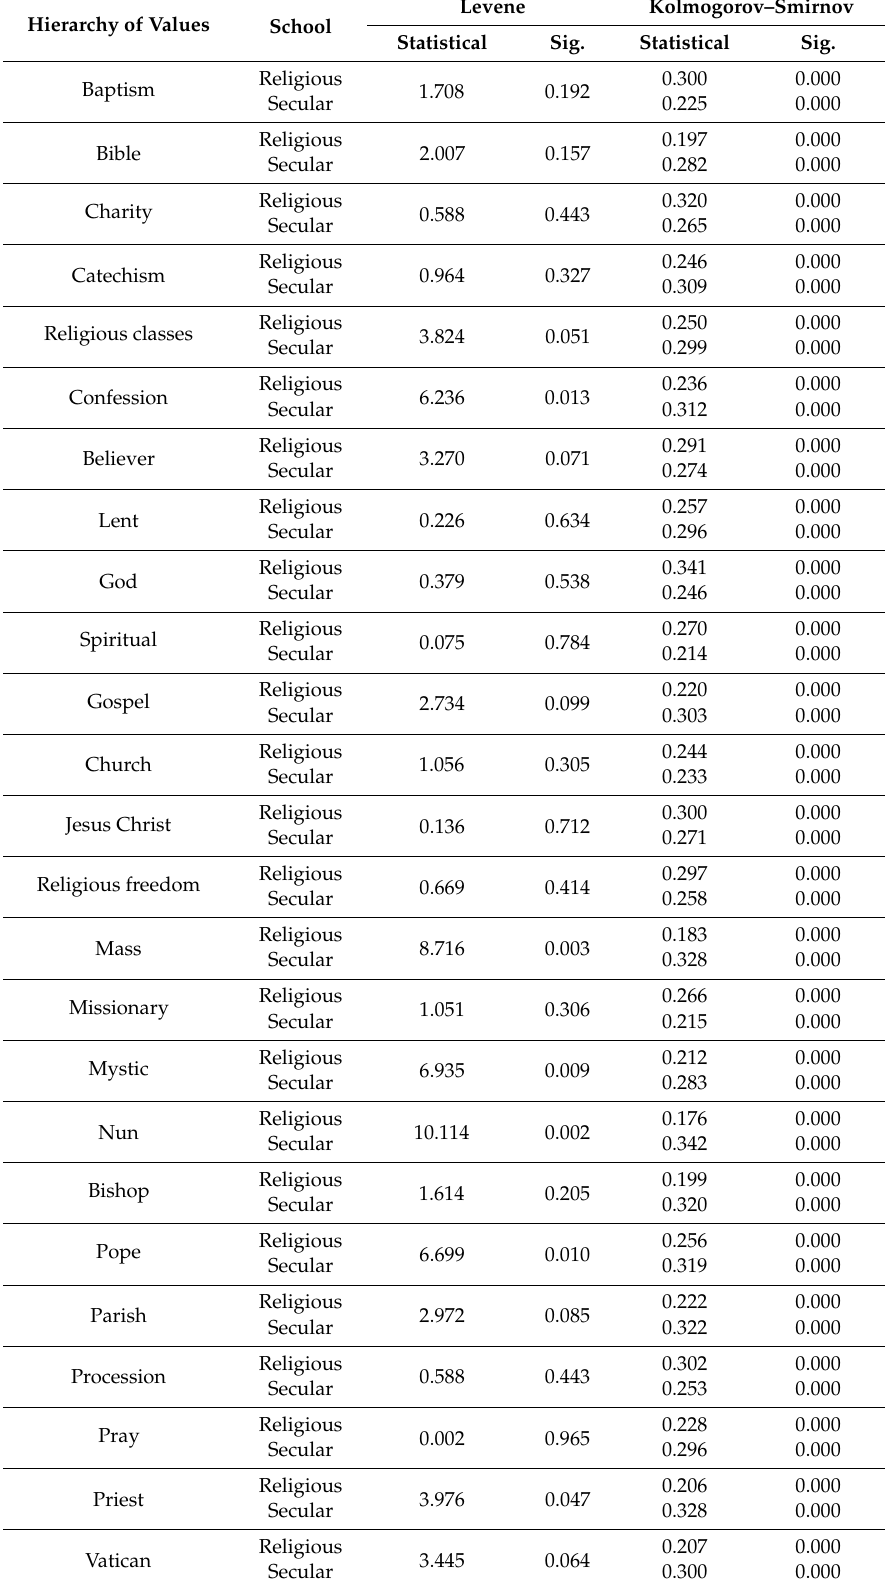
Table A2. Results of the parametric assumptions for the school variable (religious values). Hierarchy of